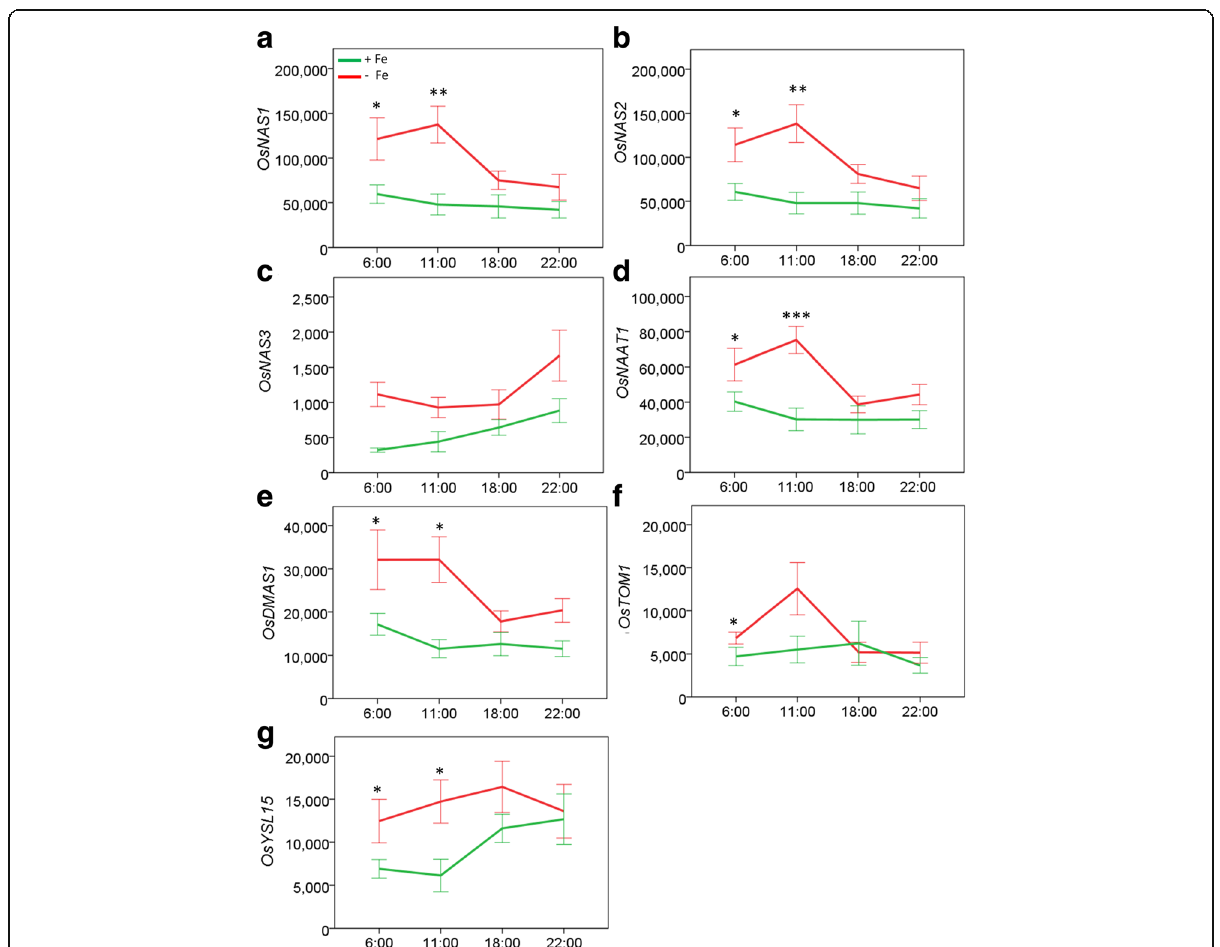
Fig. 2 Expression of genes associated with DMA biosynthesis in Fe-sufficient and Fe-deficient rice roots. Expression of a OsNAS1 , b OsNAS2 , c OsNAS3 , d OsNAAT1 , e OsDMAS1 , f OsTOM1 and g OsYSL15 genes in the roots of Fe-sufficient ( green ) and Fe-deficient ( red ) rice plants. Data is presented as means of genes of interest (GOI) expression relative to the three gene normalization factor (3GNF)±SE of 9 biological replicates. Significant differences are indicated by * for p <0.05, ** for p <0.01, *** for p ≤ 0.001 by Student ’ s t-tests performed between treatments within collection